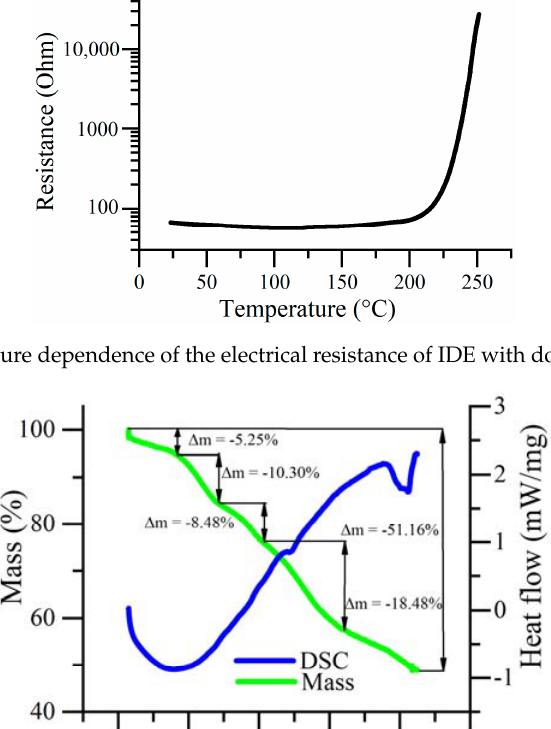
Figure 3. The temperature dependence of the electrical resistance of IDE with doped polyNiMeOSalen.